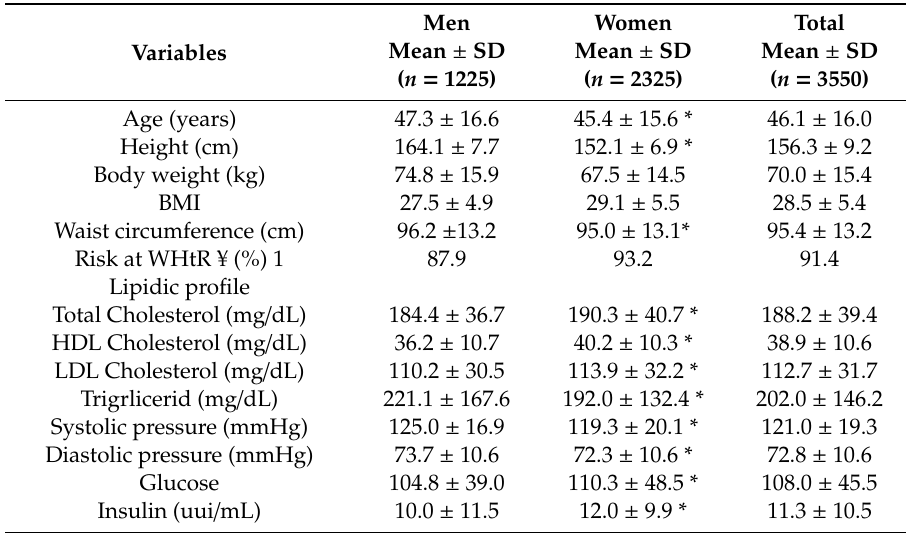
Table 1. Anthropometric and cardiovascular risk factors in adults over 20 years of age, by sex, ENSANUT MC 2016. Mexico, 2016.